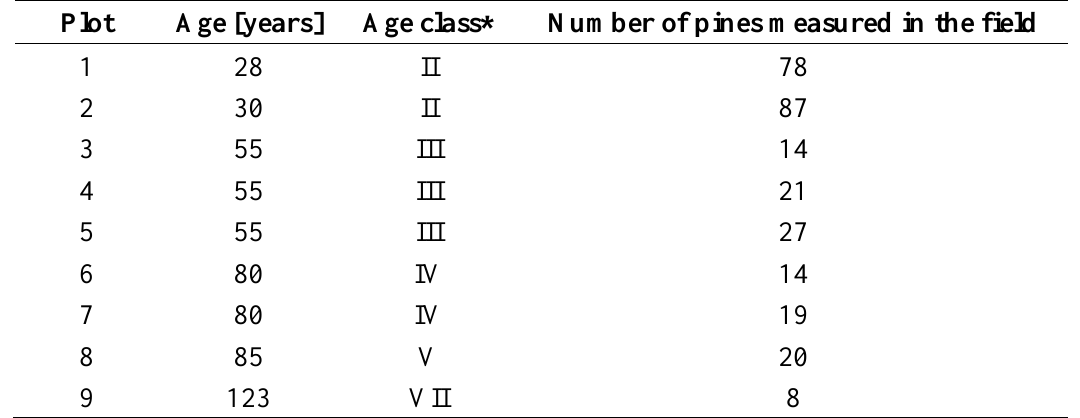
Table 3. Overview of the field plots with the mean age of the dominant tree layer and the number of pines measured in the